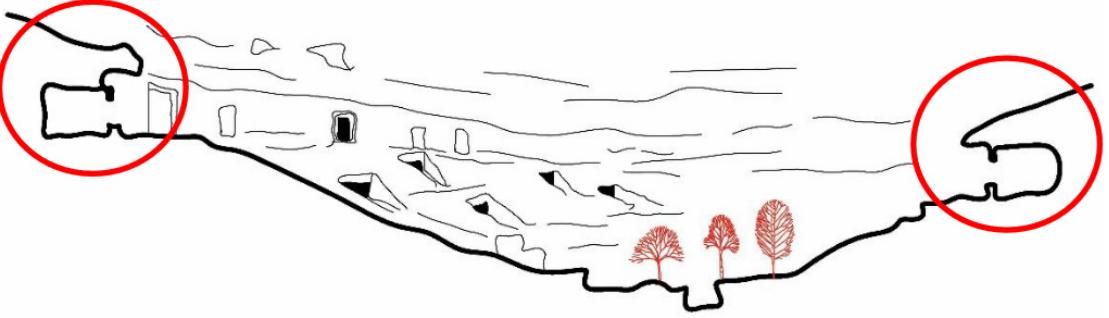
Figure 27. There are upright walls in the highest level of the village in which deep spaces are exca- vated.